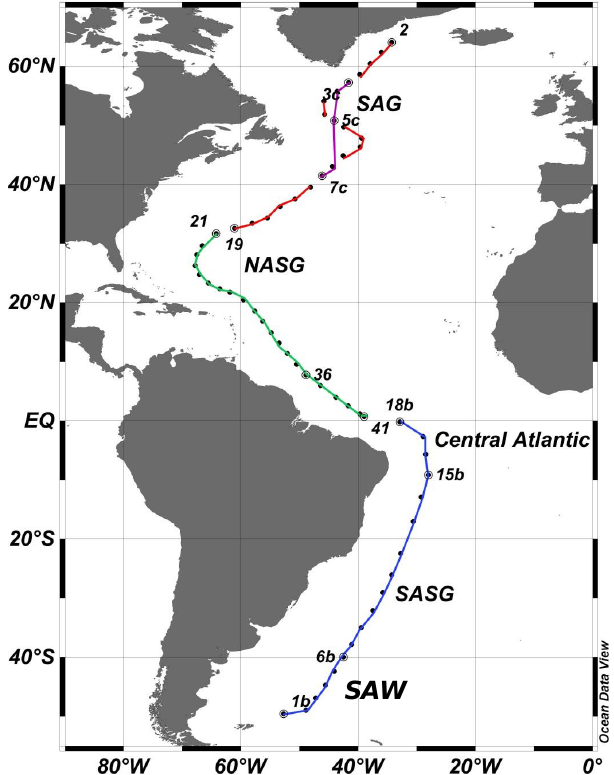
Fig. 1. GEOTRACES-A02 cruises track along the western Atlantic Ocean. Sampling locations of the four legs are shown (leg1 in red line from station 2 to station 19, leg2 in green line from station 21 to station 41, leg3 in blue line from station 1b to 18b and leg4 in purple line from station 3c to